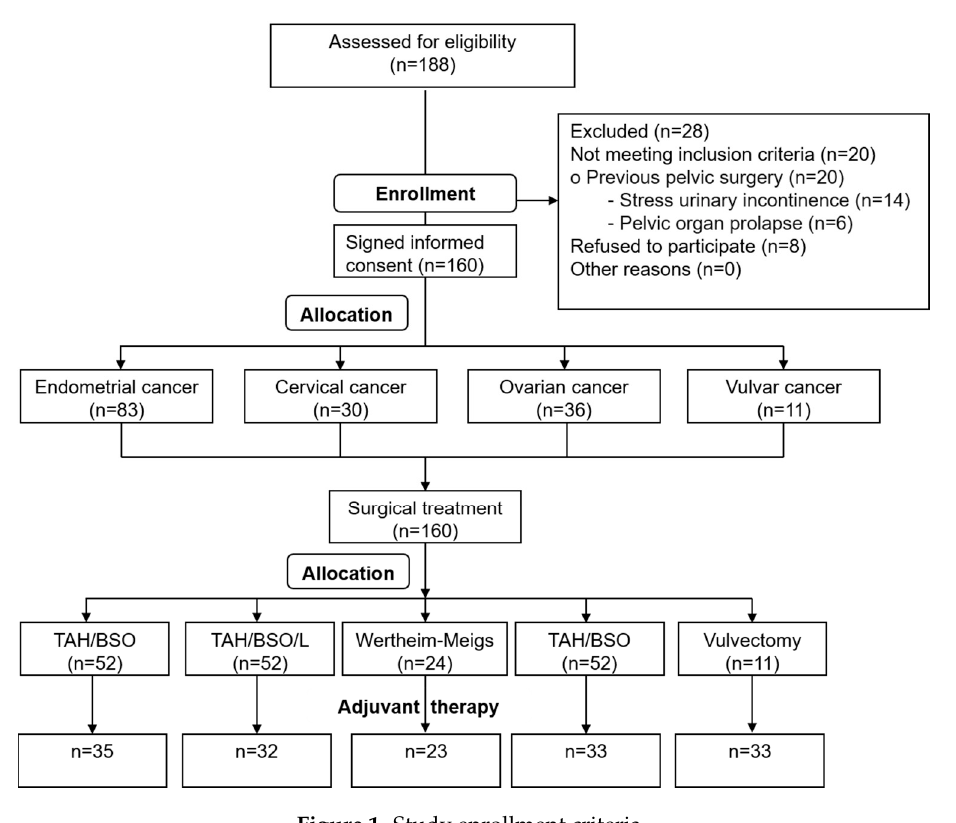
Figure 1. Study enrollment criteria.